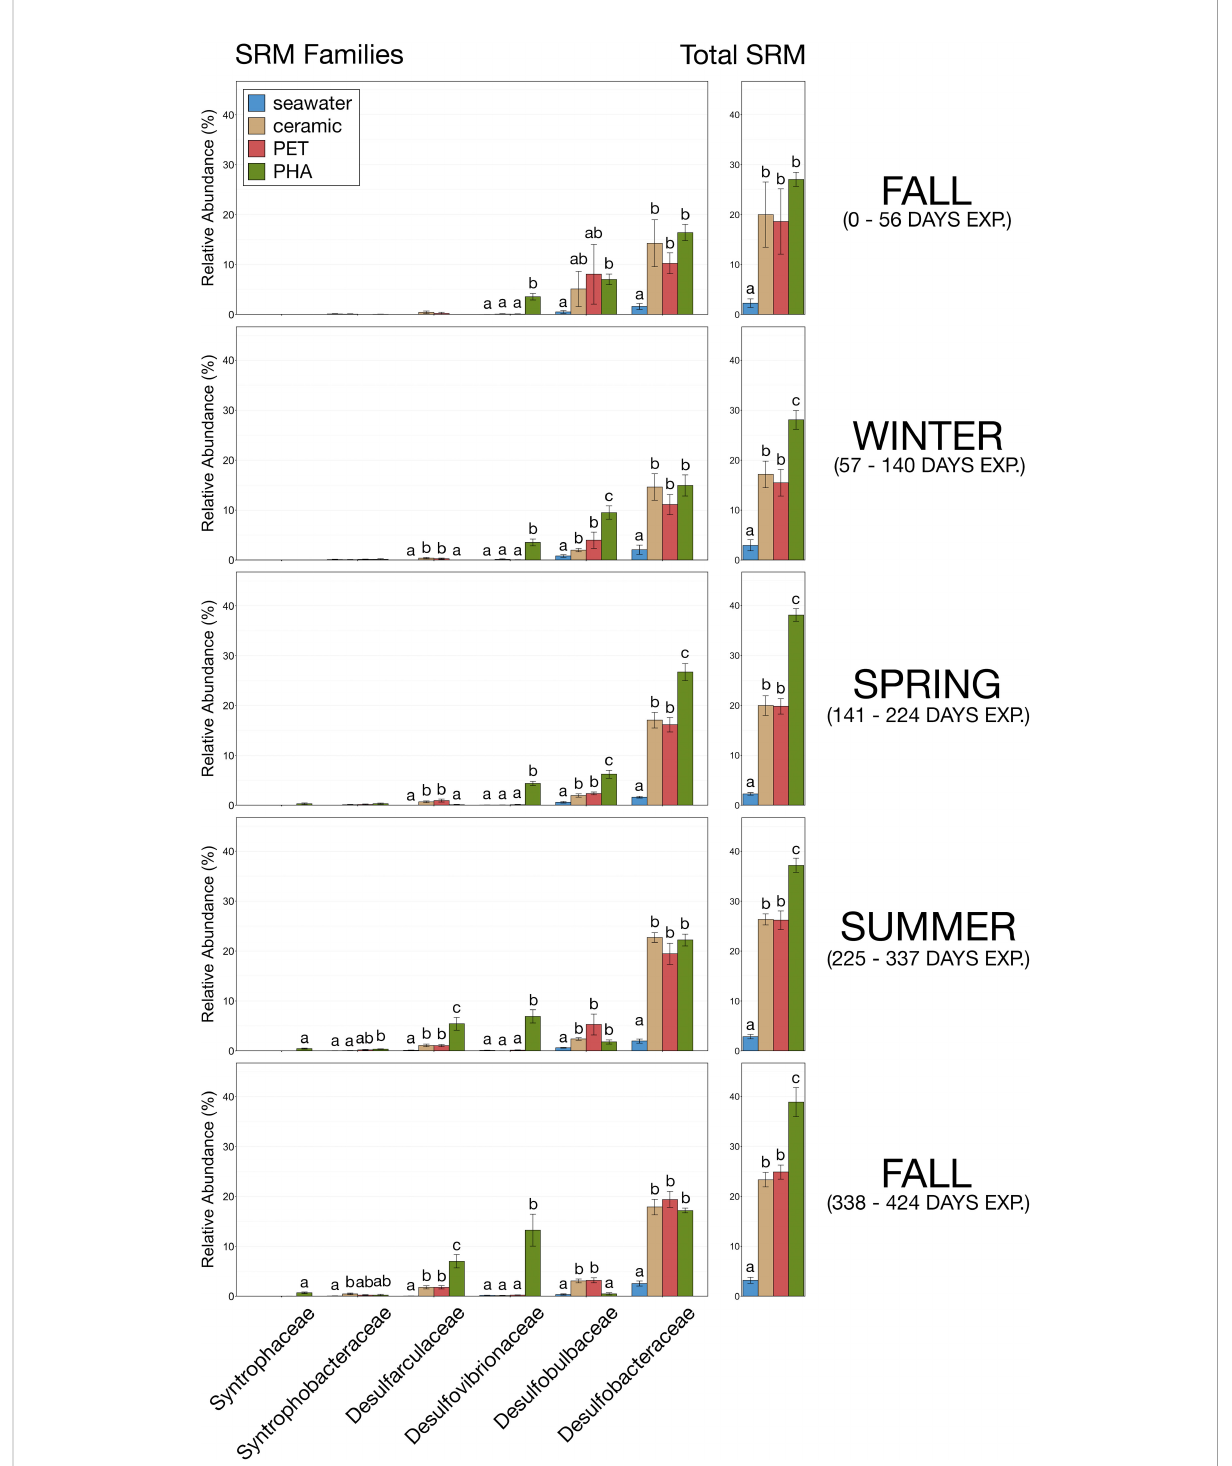
FIGURE 5 Bar plots demonstrating the relative abundances of the SRM families and total relative abundance of SRM within each type of microbial community (seawater, ceramic, PET, PHA) during each of the fi ve stages: fall 2016 (0 – 56 days exposure), winter 2016 (57 – 140 days exposure), spring 2017 (141 – 224 days exposure), summer 2017 (225 – 337 days exposure), and fall 2017 (338 – 424 days exposure). Error bars display standard error of the mean and signi fi cant differences in relative abundances are illustrated by different letters (pairwise Wilcoxon rank-sum with Benjamini-Hochberg correction, p-value< 0.05,